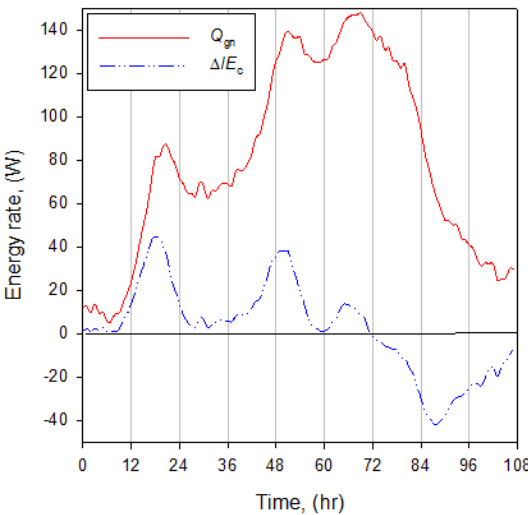
Figure 8. The total energy generation rate and the change of internal energy of compost during the composting process.